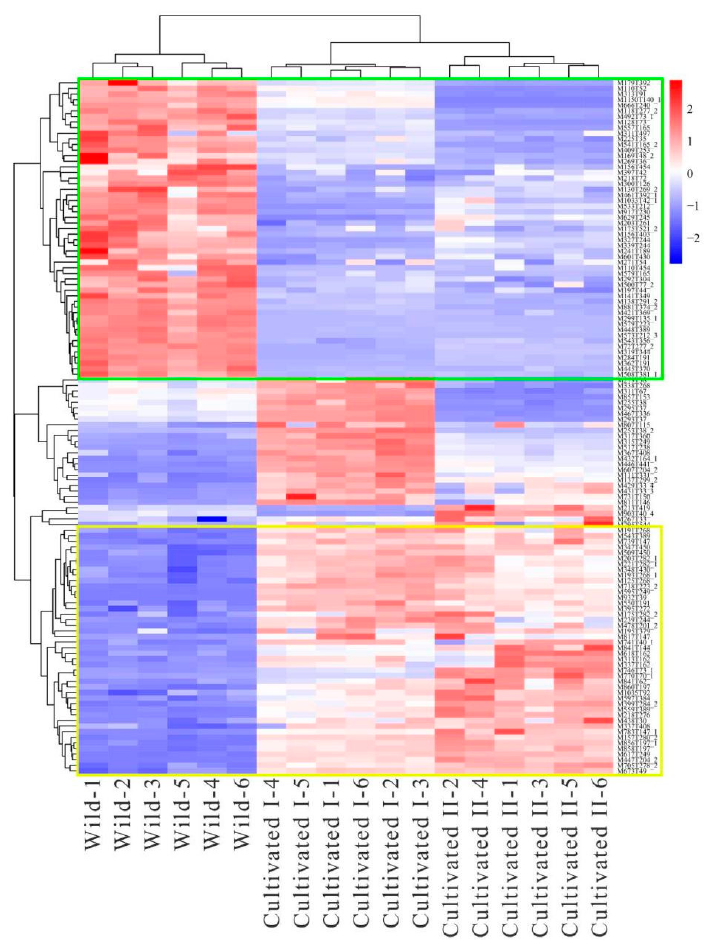
Figure 8. Cluster heat map of significantly different metabolites from different sources of YCH. Metabolites marked in the green box are potential characteristic metabolites of Wild; metabolites marked in the yellow box are potential characteristic metabolites of Cultivated I and Cultivated II.